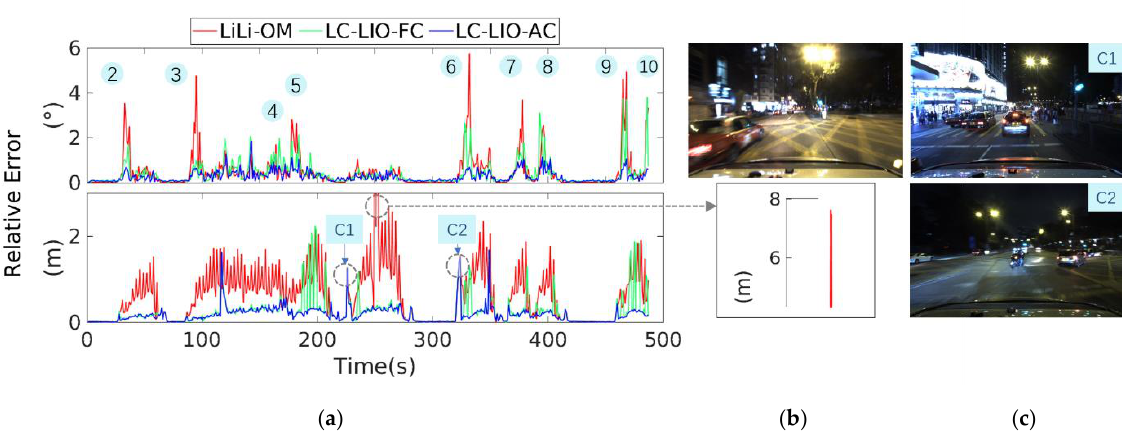
Figure 14. The RPE of LiLi-OM, LC-LIO-FC and LC-LIO-AC on the entire trajectory of one experiment in the urban canyon 2. The number corresponds to the places marked in Figure 13a. ( a ) The top panel is the RRE and the bottom panel is the RTE of the three methods. ( b ) The top panel is the image captured when the RTE of LiLi-OM reaches up to 8 meters. The bottom panel is the zoomed-in RTE for LiLi-OM at that point. ( c ) The images are captured when the RTE of all the three methods is equally large as illustrated in ( a ).